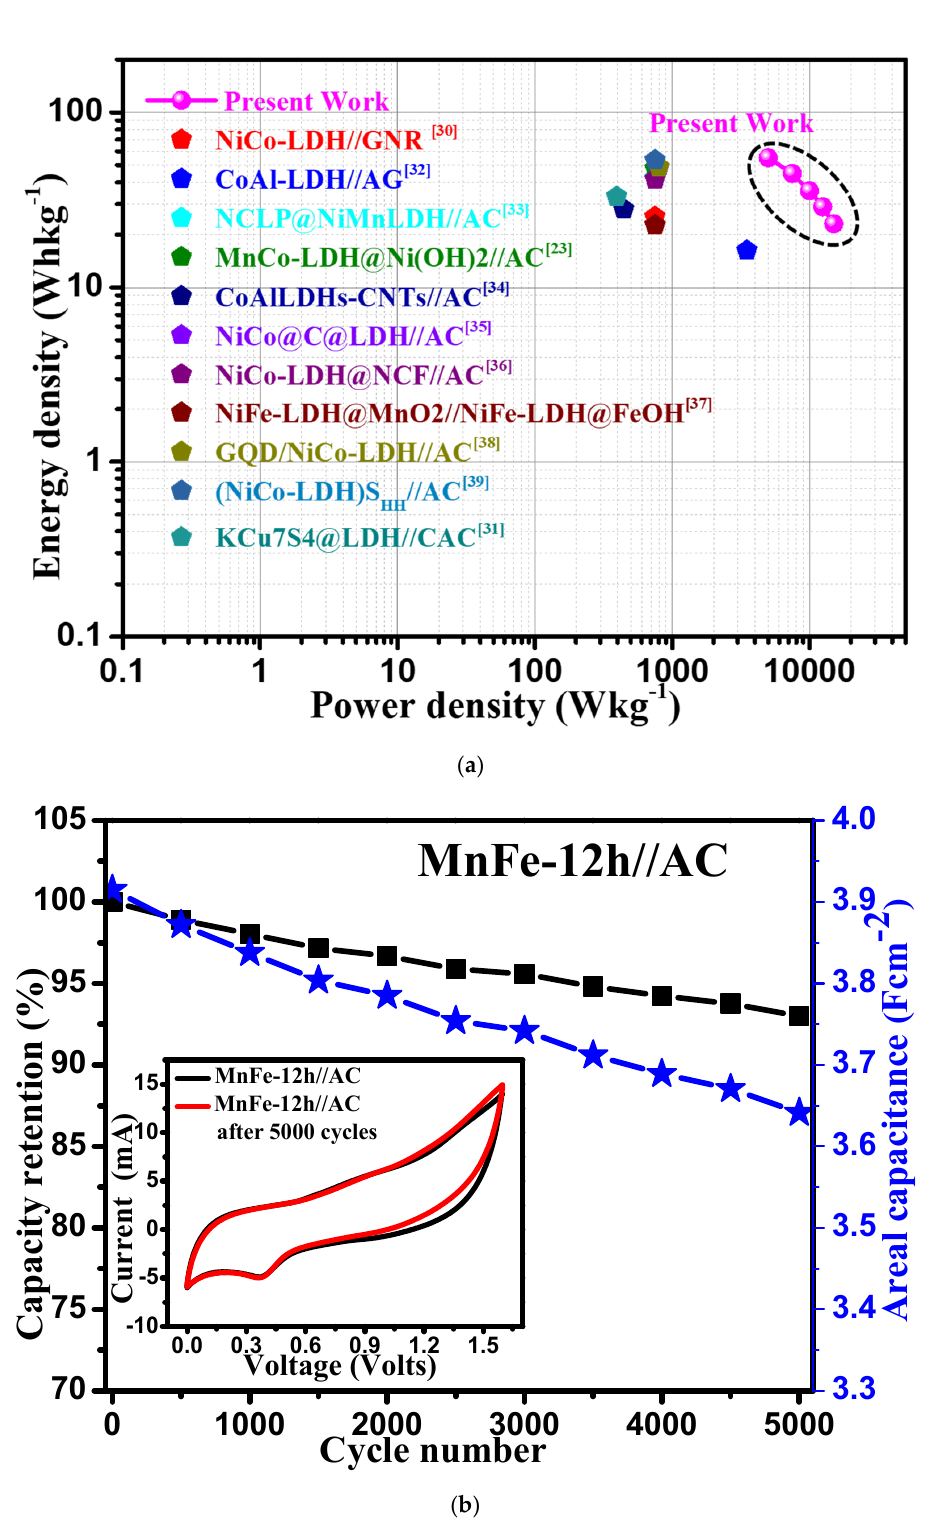
Figure 9. ( a ) Ragone plot, for the MnFe-12h//AC asymmetric cell device. ( b ) Cycling performance of the MnFe-12h//AC asymmetric cell device measured at 10 mVs −1 . Inset: CV curves obtained for 1st cycle and 5001st cycles at 10 mVs −1 .